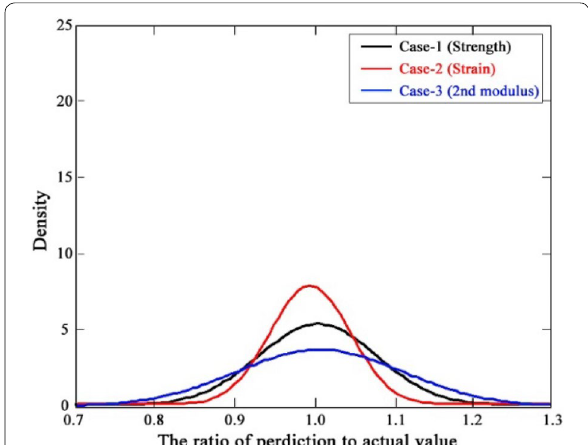
Fig. 6 Error ratio of prediction and actual data on statistical analysis.